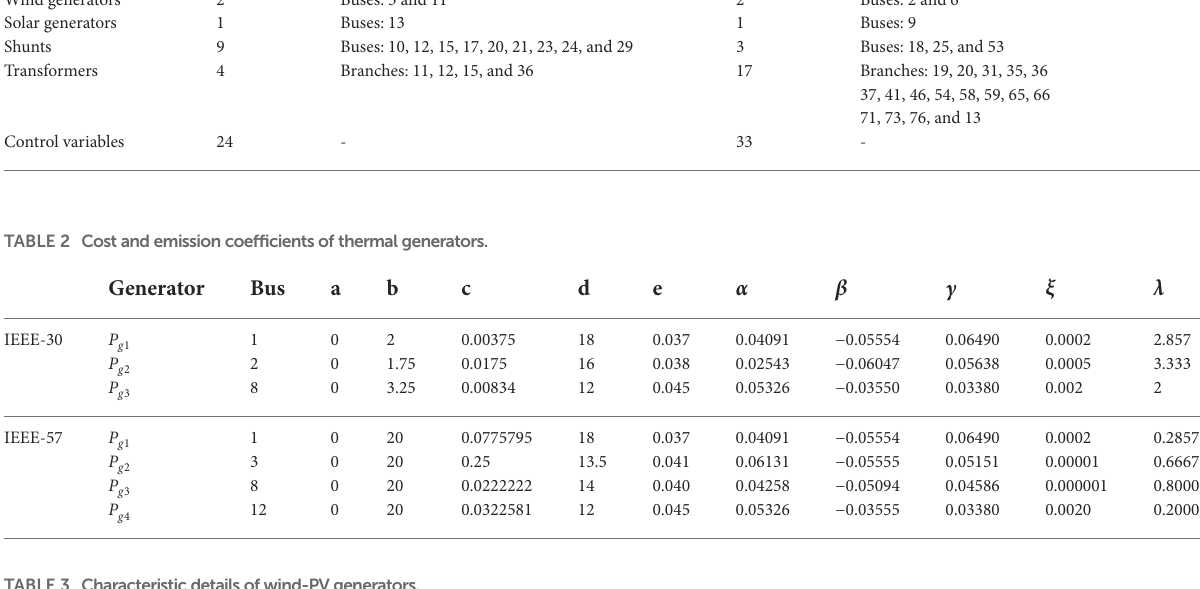
TABLE 3 Characteristicdetailsofwind-PVgenerators.